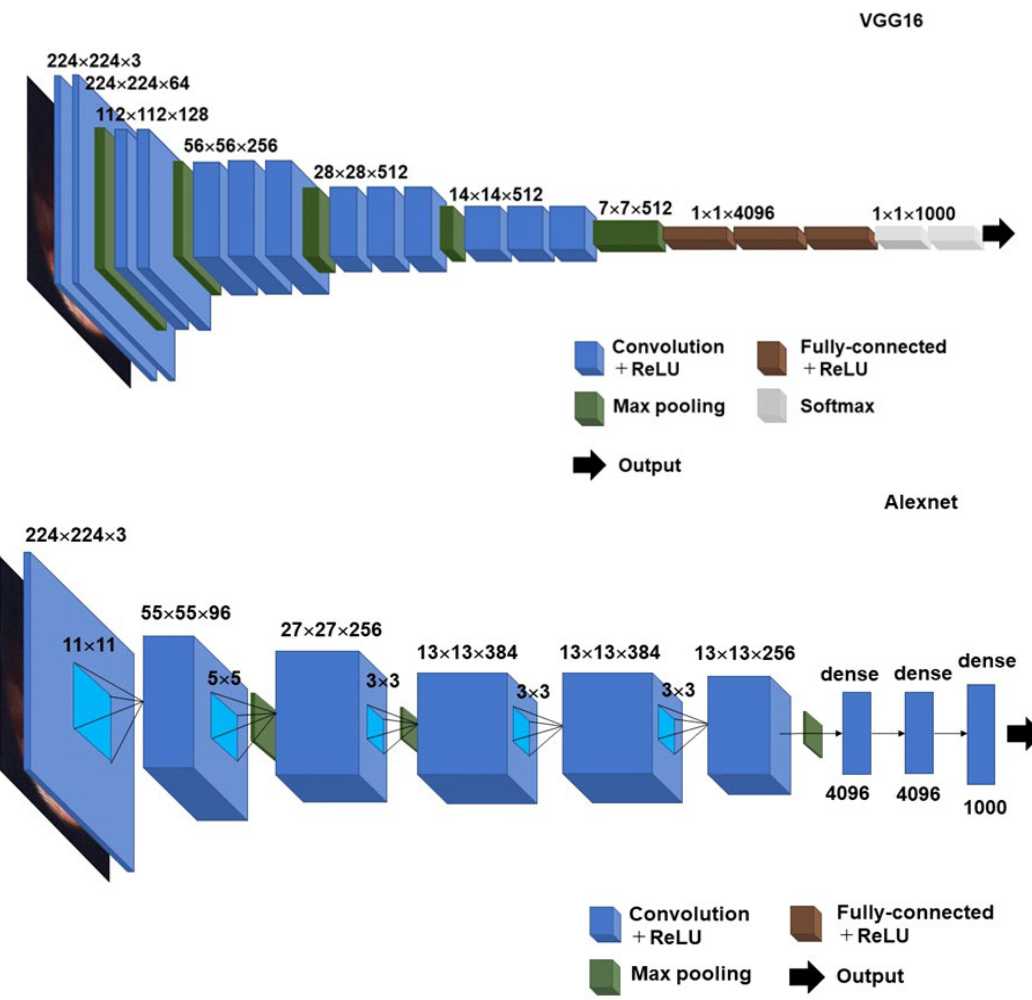
Figure 2. Basic architecture of VGG16 CNN model.